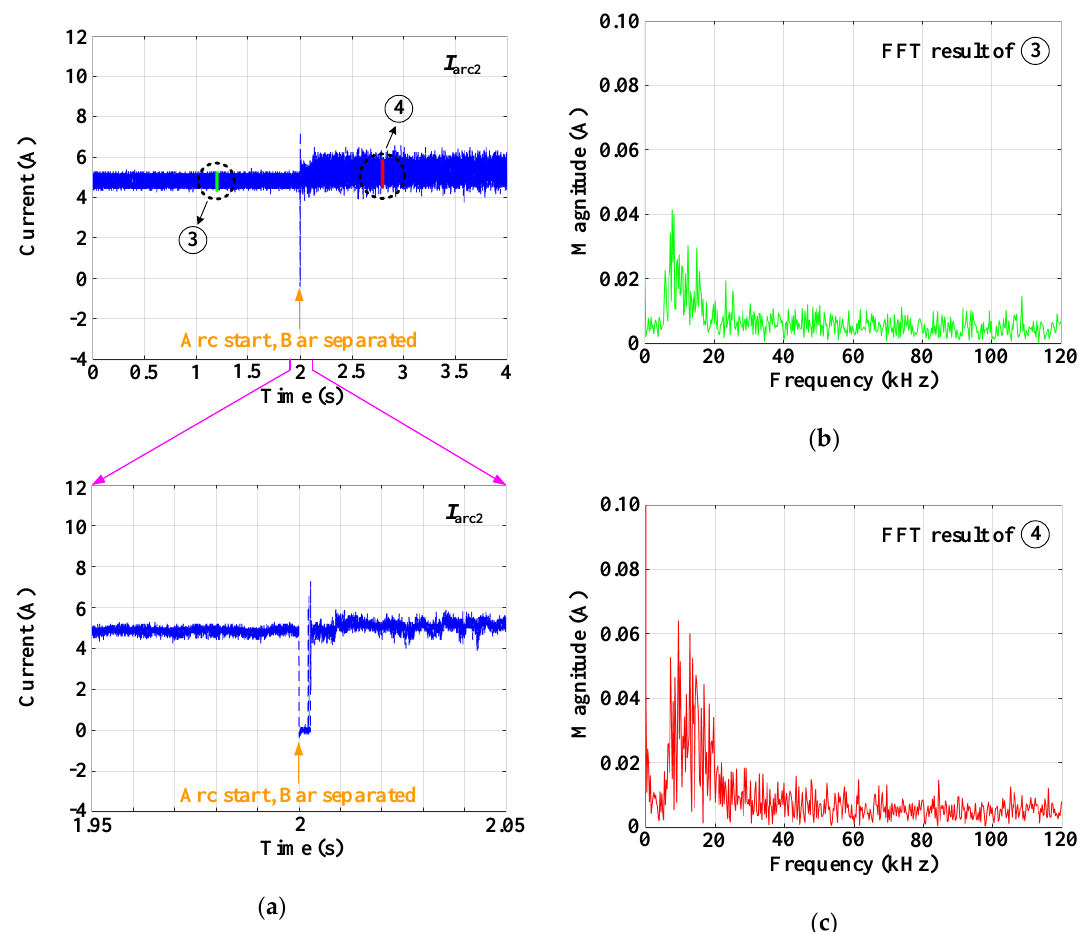
Figure 6. Current waveform and FFT results of 𝐼 𝑎𝑟𝑐2 when the magnitude of current is 5 A and average switching frequency is 20 kHz: ( a ) current waveform, ( b ) FFT result before arcing, and ( c ) FFT result after arcing.